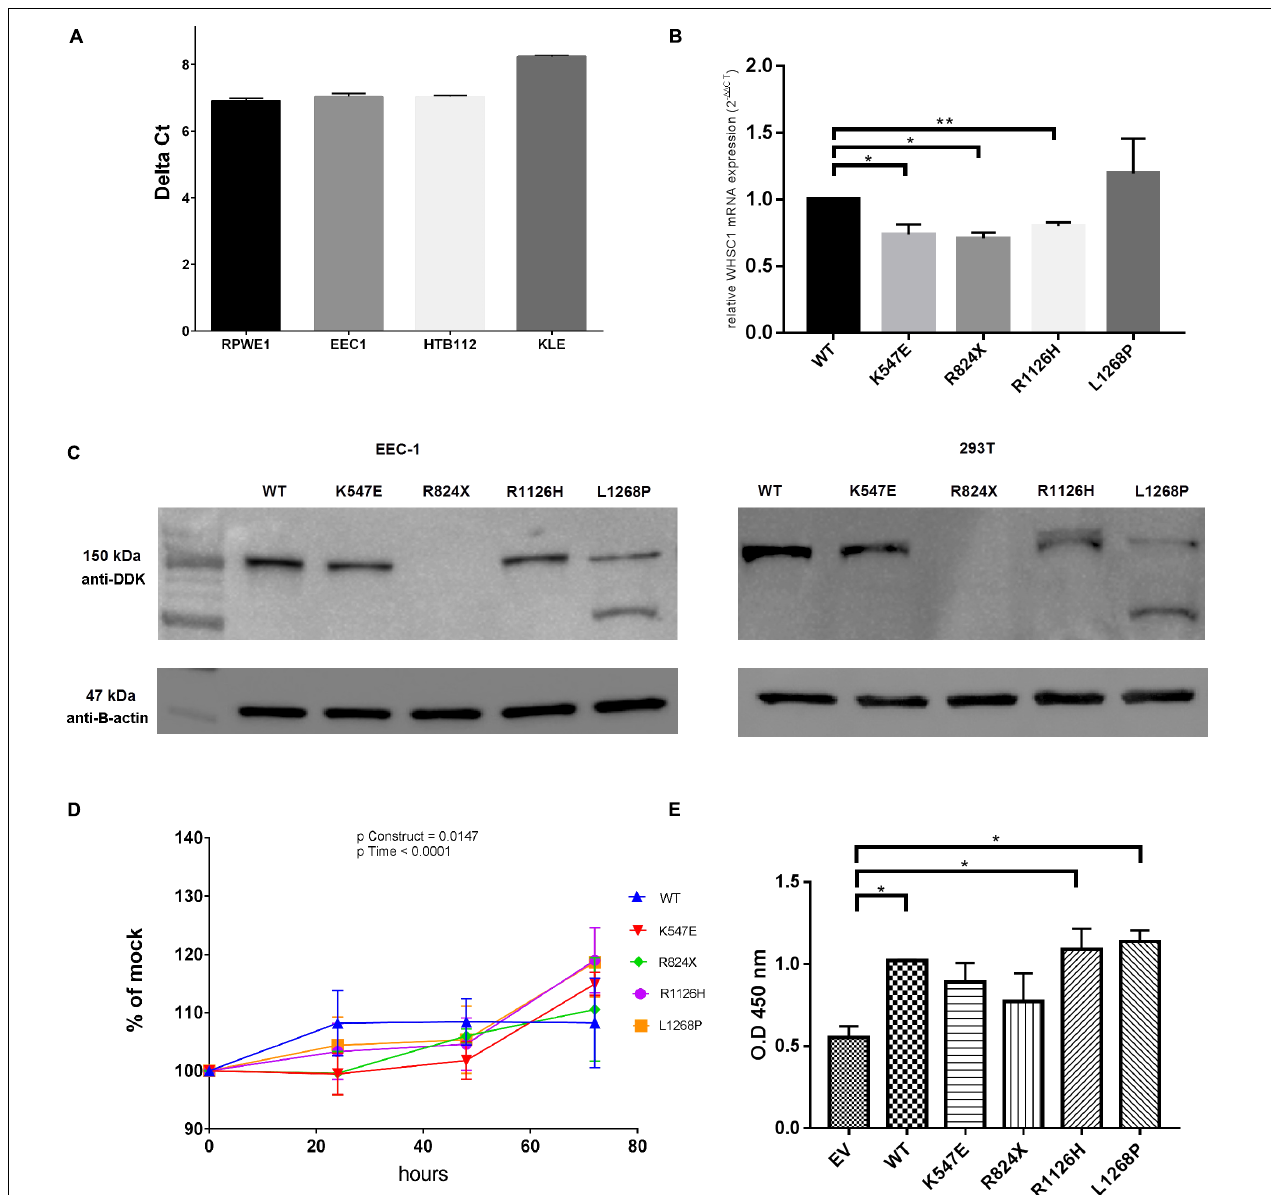
FIGURE 3 | WHSC1 gene and protein analysis. (A) Quantification of mRNA from nuclear extract of normal prostate cell lines RPWE1 and endometrial cancer cell lines (EEC-1, HTB-112, KLE). (B) Quantification of mRNA expression of mutant WHSC1 in EEC-1 cell line. Relative WHSC1 mutants were calculated in comparison to WT WHSC1 48 h post-transfection by real-time PCR and normalized to GAPDH mRNA expression. Negative control (no template) was included in each experiment (mean ± SD, n = 2, ∗ p < 0.05). The mRNA expression of WT was assigned as 1. (C) Western blot analysis shows protein expression of wild type and WHSC1 mutants in EEC-1 and 293T cell lines after 48 h post-transfection. Total protein harvested from EEC-1 cells and 293T cells solubilized in cell lysis buffer were analyzed using precast SDS 4–12% gels. The WT and mutants of WHSC1 (152.1 kDa) were detected using Anti-DDK Clone OTI4C5 (mouse origin). While β -actin (47 kDa) was detected using anti- β -actin (mouse origin) for positive control. Mutants WHSC1 promote cell growth. (D) Mutants WHSC1 promote cell viability. At 72 h, the mutants K547E, R1126H, and L1268P resulted in 15, 19, and 18% increase significantly in motility, respectively, over EV in EEC-1. Statistical significance in all cases was measured by Student’s t -test ( ∗ p < 0.05), n = 3. Error bars represent average ± SD. Overall p -values were calculated by two-way ANOVA for time. (E) Mutants WHSC1 promote cell proliferation. BrdU colorimetric incorporation assay shows that wild type of WHSC1 , R1126H, and L1268P significantly increased cell proliferation in EEC-1. Statistical significance in all cases was measured by Student’s t -test ( ∗ p < 0.05), n = 2. Error bars represent average ± SD.